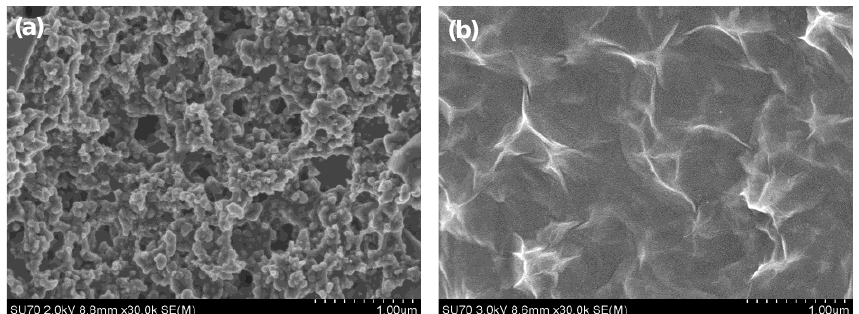
Figure 3. SEM images of ( a ) bare SPCE and ( b ) rGO modified SPCE as working electrode.